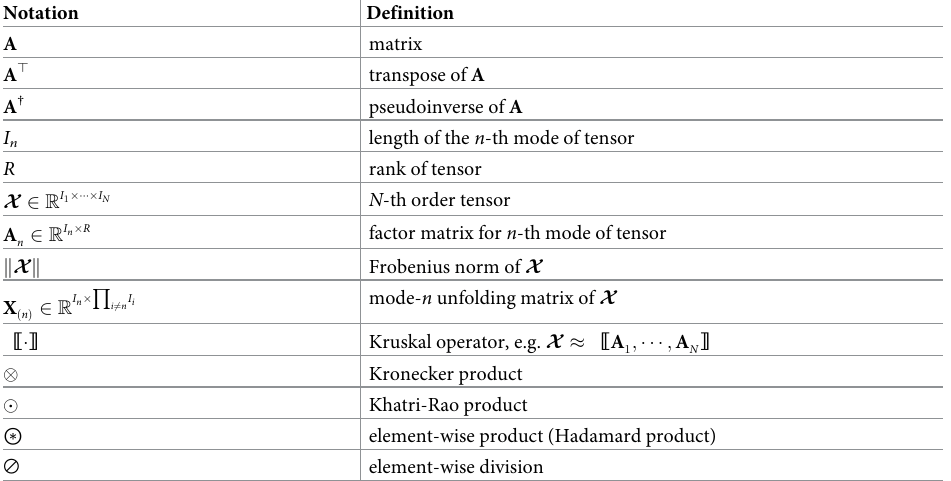
Table 1. Table of